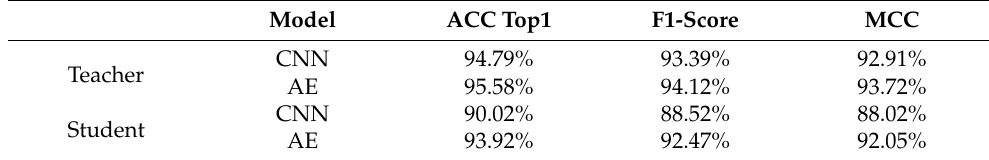
Table 5. Casting dataset experiment results.